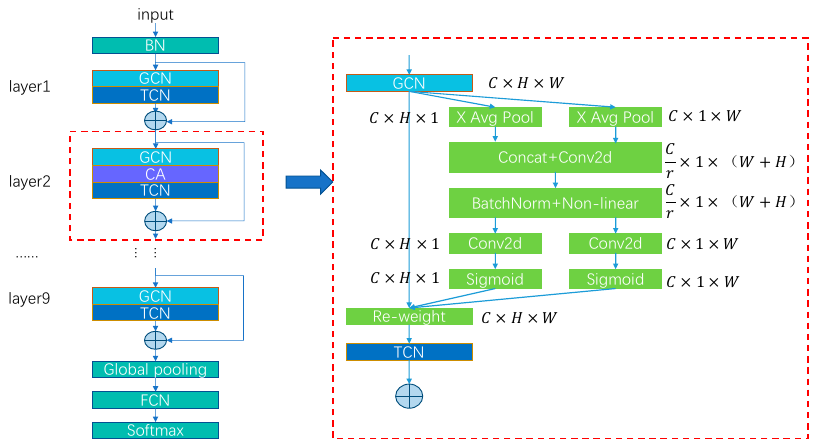
Figure 4. Network structure diagram of STGCN-CA.